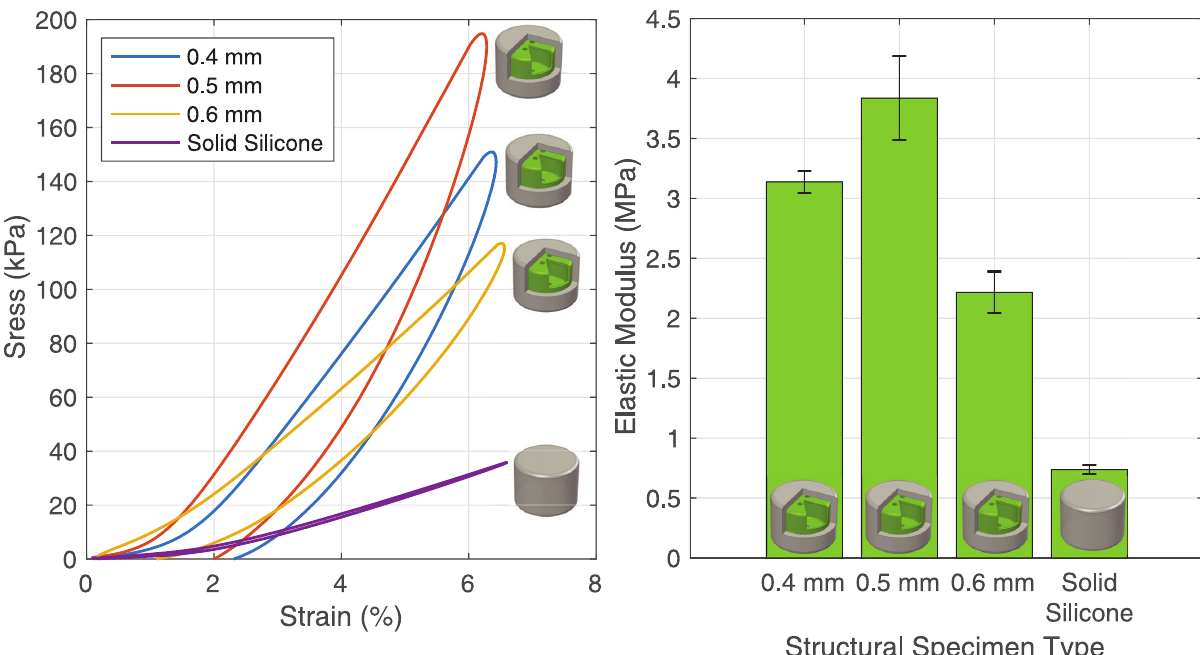
Fig 12. Structural core results. (Left) The stress-strain curve of the tested specimens show that the stiffness of the specimens can be greatly increased with the structural cores. (Right) The elastic modulus of the different structural cores.